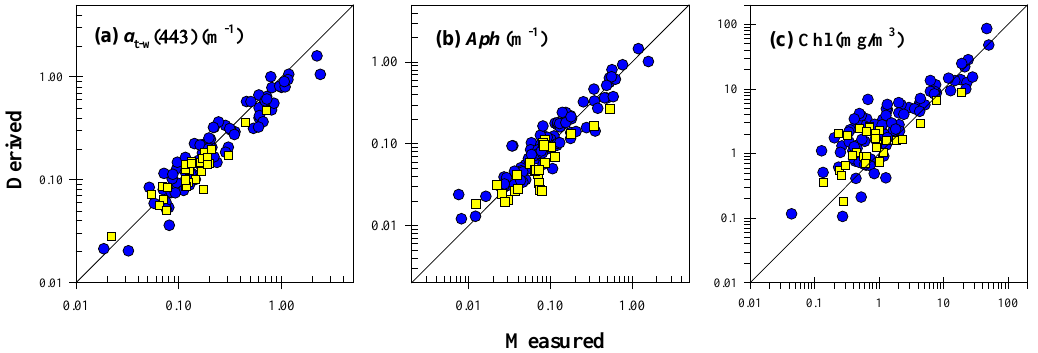
Fig. 2. Scatter plot of R rs (in situ: blue circles; MODIS: yellow squares) derived (a) a t - w (443), (b) Aph and (c) Chl versus field measured data. Fig. 2 Scatter plot of R